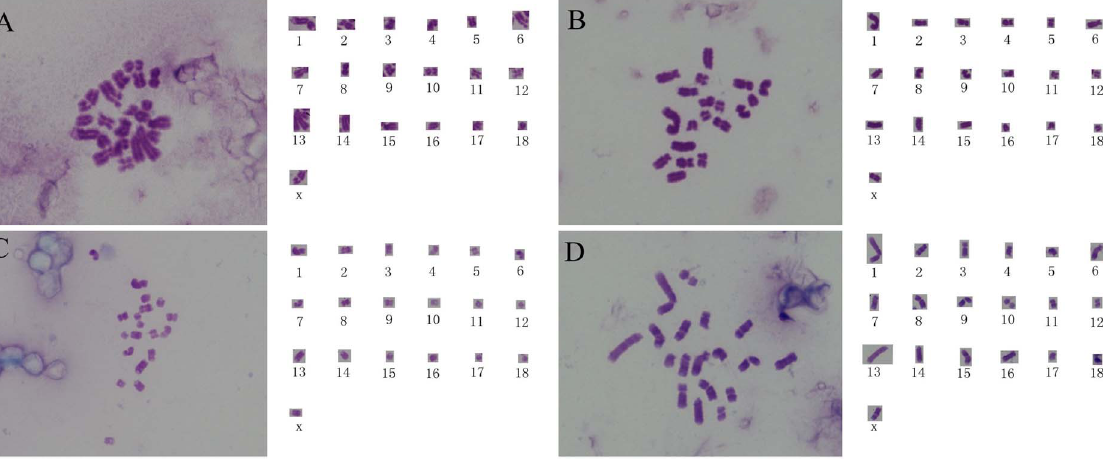
Figure 1. The chromosome spread and G-banding analyses of blastomeres from 8-cell to 16-cell parthenogenetically activated embryos. (A and B) The chromosome spread and corresponding chromosome alignment of haploid blastomeres; (C and D) The G-banding karyotype and corresponding chromosome alignment of haploid blastomeres.